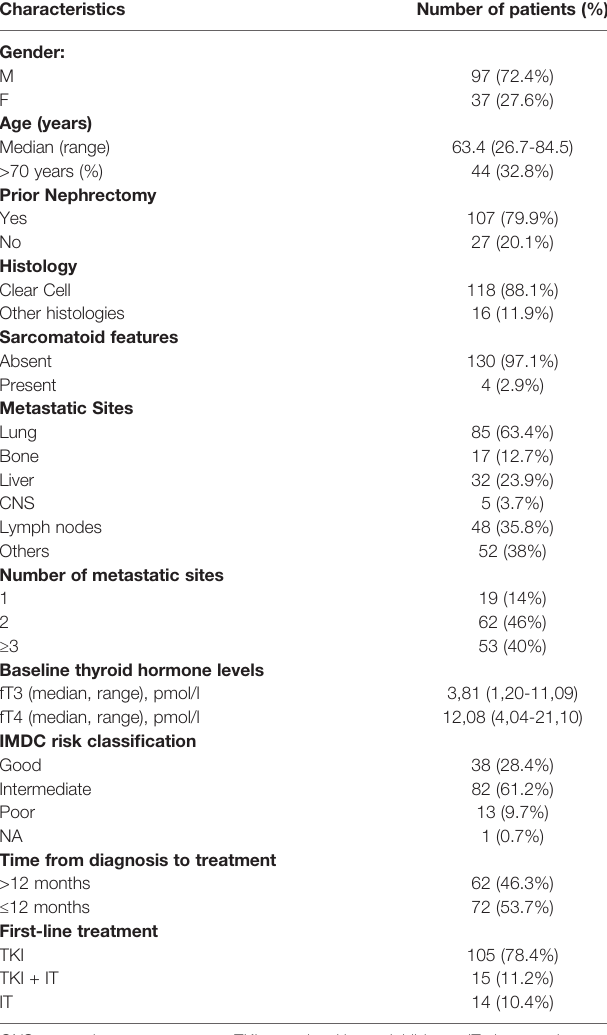
TABLE 1 | Patient characteristics (N =